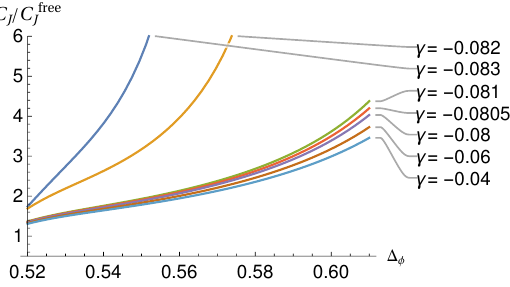
Figure 12 . Upper bound on C J normalized to the central charge of a free complex boson as a function of ∆ φ at fixed values of the parameter γ assuming C T ≤ 0 . 95 C free obtained at Λ = 13